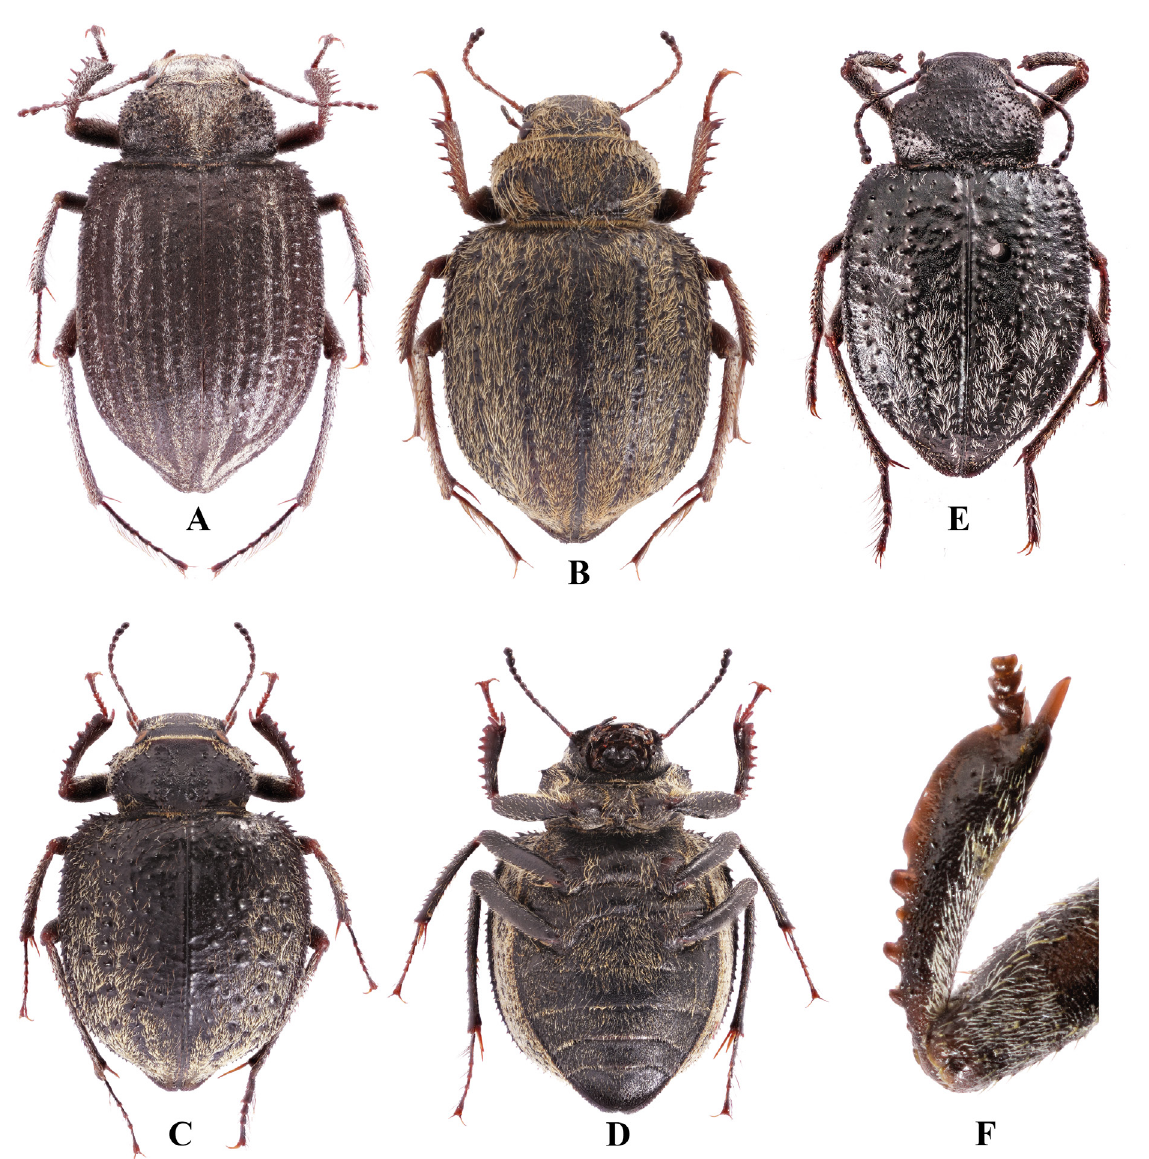
Fig. 7. Species of the genus Earophantha Semenov, 1903, habitus, details of structure. A . E. collaris (Fischer von Waldheim, 1844), ♂ (ZIN), dorsal view. B . E. planidorsis (Reitter, 1889), ♂ (ZIN), dorsal view. C . E. serrata (Semenov, 1893), ♂ (ZIN), dorsal view (ZIN). D . Ditto, ventral view. E . E. beludzhistana Bogatchev, 1957, ♂, holotype (ZIN), dorsal view (ZIN). F . Ditto, right protibia, not to